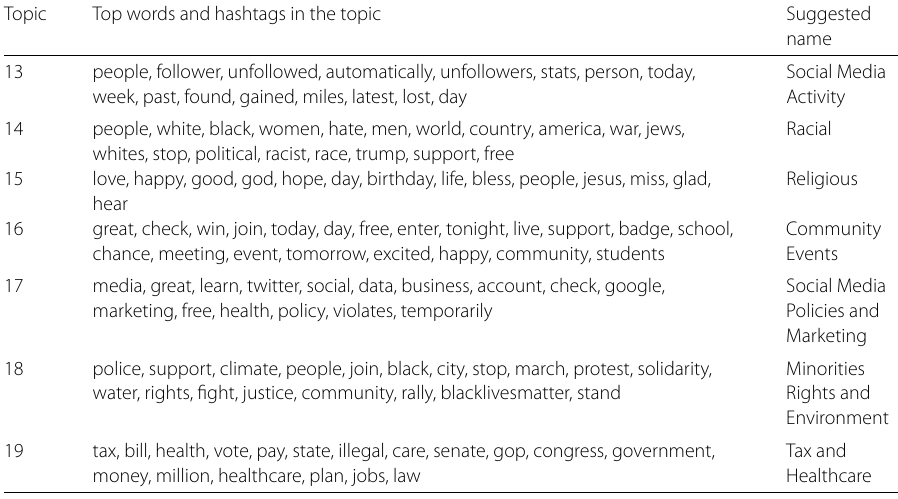
Table A4 Multi-group mean comparisons of certainty in 25% sample size data using Tukey’s HSD test